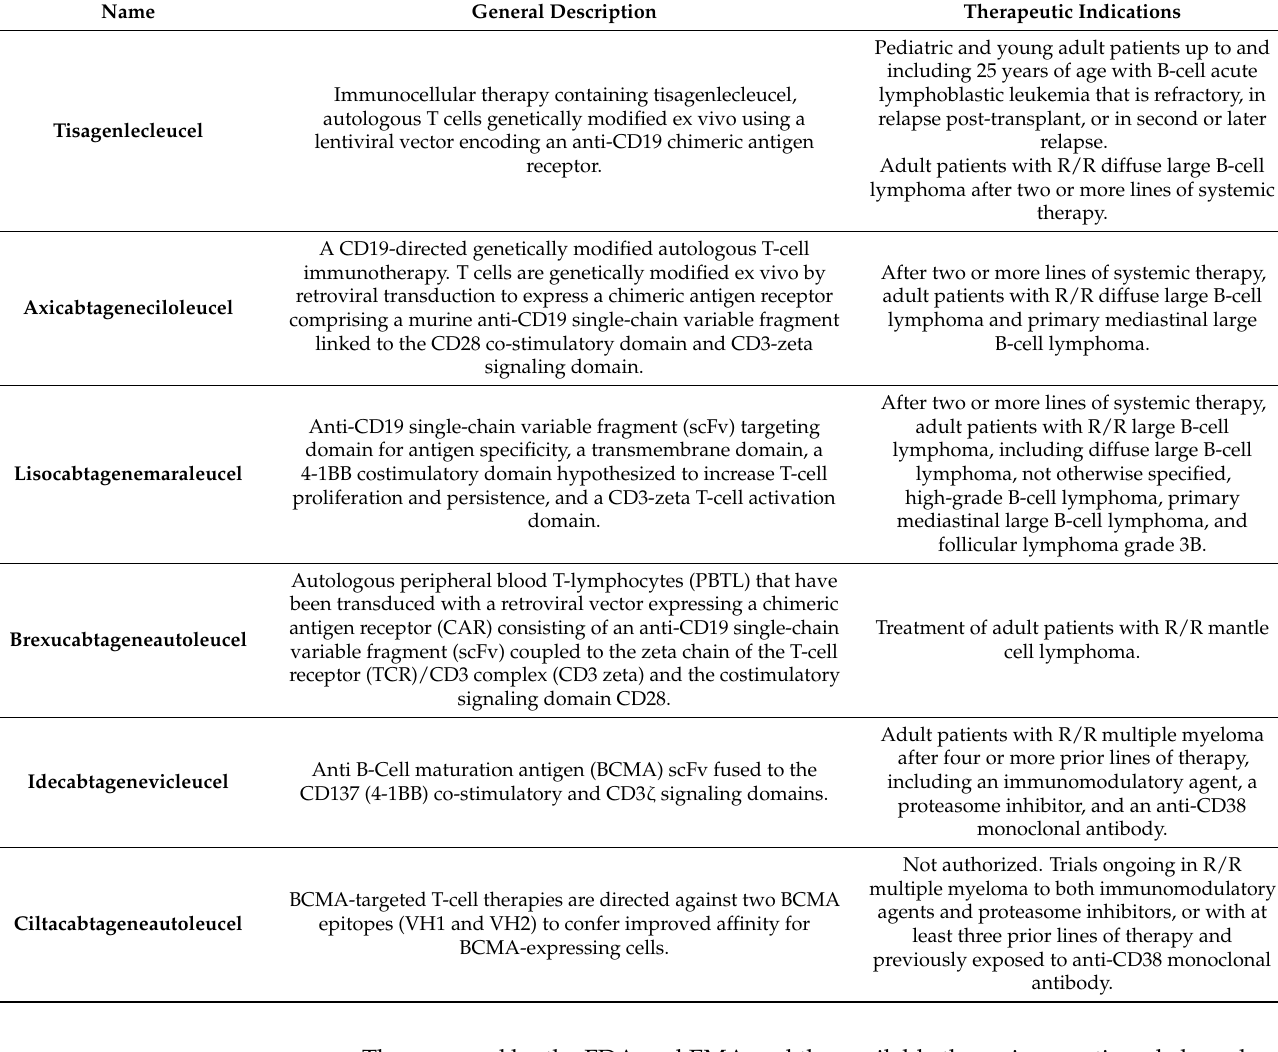
Table 1. Main characteristics of the CAR-T constructs and clinical